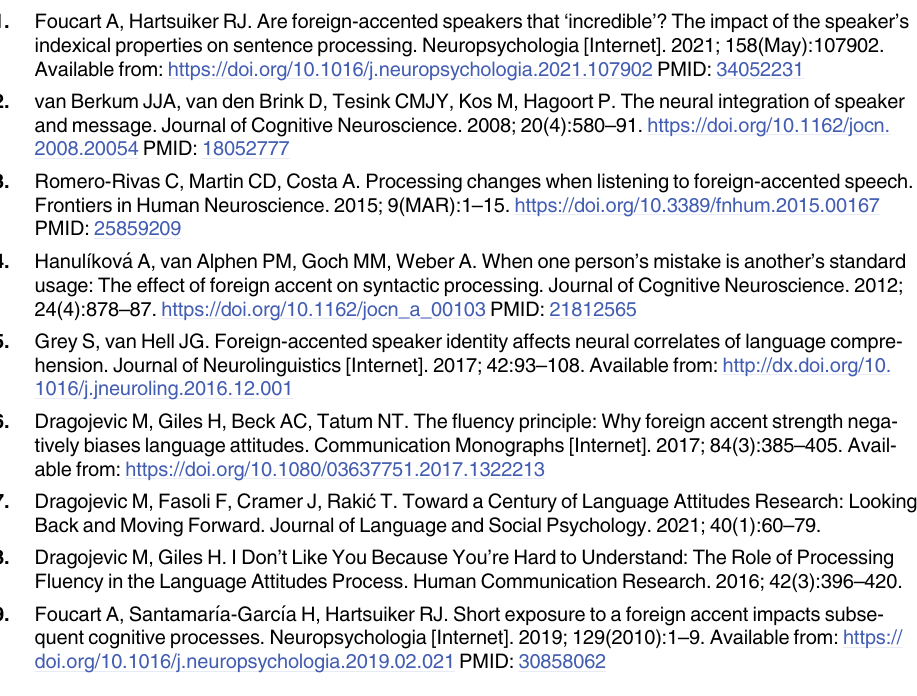
S2 Table. English translation of the everyday social norms included in Task 1 of Experi- ment 2 (norms marked with ‘ � ’ were not included because of a low rating in the pre-test). Means (SDs) refer to the rating attributed to the norms in the pre-test. The structure of the sentences was adapted to match the Spanish translation of the questions ‘How likely are you to respect the norm . . . ’ (Respect variable) and ‘How wrong is it to . . . ’ (Wrong social variable). S3 Table. Estimates, standard error, t-values, and p-values of the predictor Accent (native, foreign-Indo, foreign-Arab) in interaction with Accent Strength, Comprehensibility and Education on